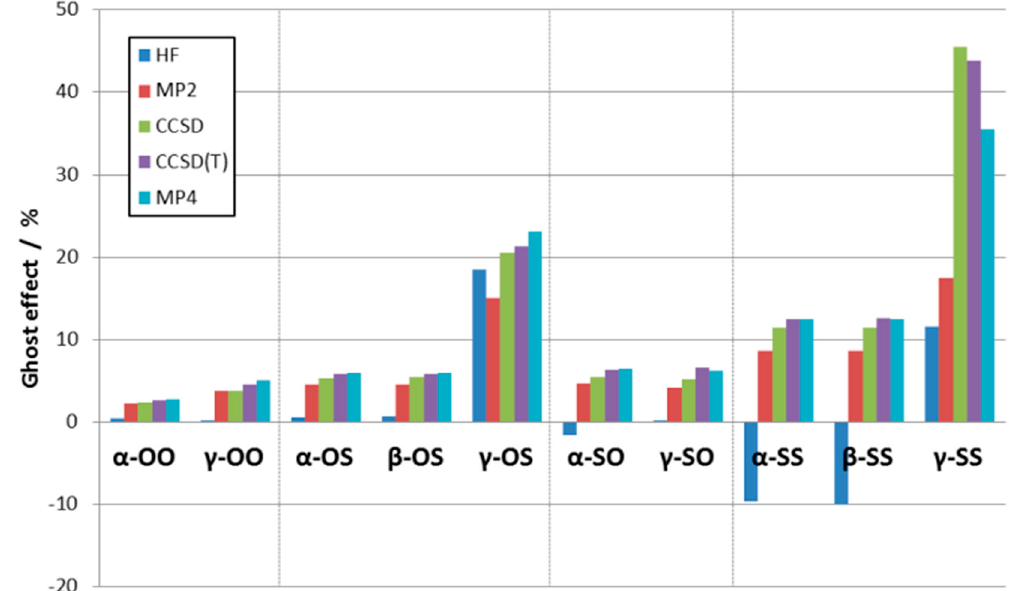
Figure 3. Bar graph illustrating the percentage effect of the placement of the mid-bond ghost atom on the supermolecular interaction energy.